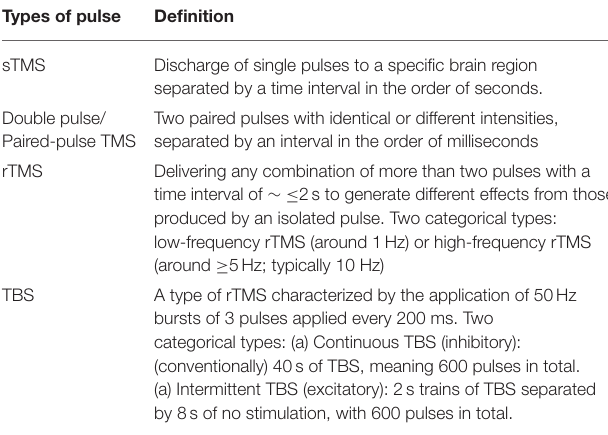
TABLE 1 | Types of TMS pulses (2, 8). Types of pulse